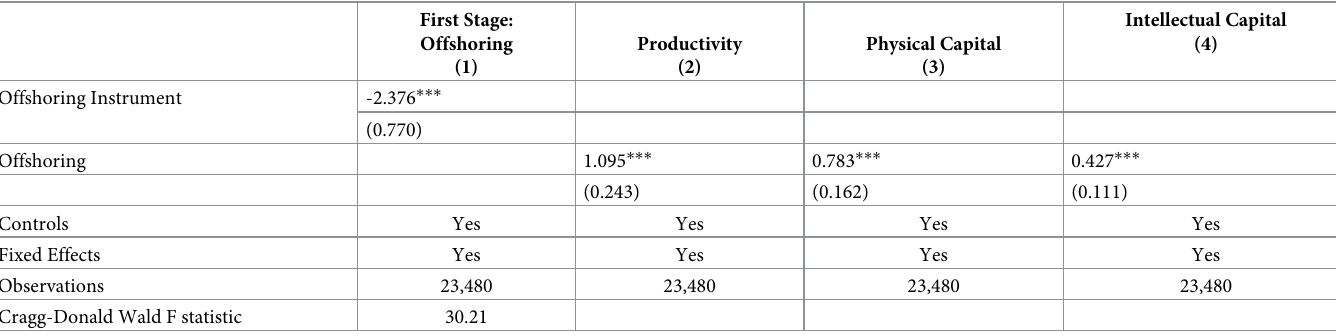
Table 2. Offshoring effects on productivity and capital